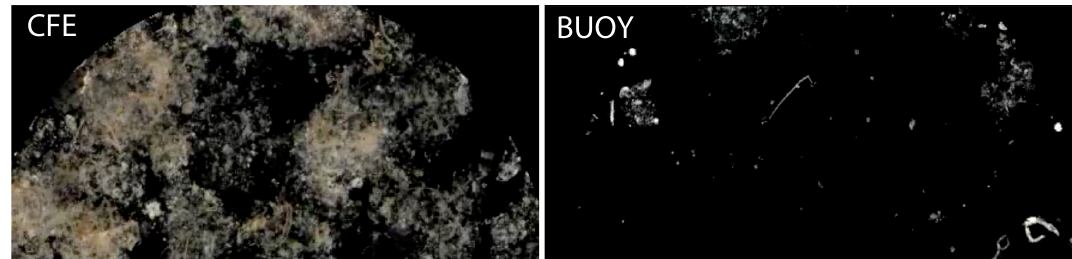
Figure 9. Comparison of representative dark field images of accumulated settling particles over a 1.8h period from an optical sedimentation recorder (OSR) on the Carbon Flux Explorer (CFE, left) vs. that from a surface BUOY-tethered OSR (right) during NH1301 (January 2013). The CFE was observing sedimentation at 320m (image 21:14UTC). The BUOY-OSR was deployed at 237m (image 18:07UTC). Each image is 2.5cm across and pixel resolution is 13µm. The large fluffy 0.5–1.0cm sized marine-snow aggregates were almost completely missed by the BUOY OSR. Winds were near calm (<5ms − 1 ) and surface waves and swell were almost entirely absent. The BUOY system had ∼ 0.5 ◦ of tilt. The only difference between the CFE and BUOY was the absence and presence of tidally fluctuating horizontal currents of up to 8cms − 1 . Only fragments of the aggregate particles were seen in the BUOY